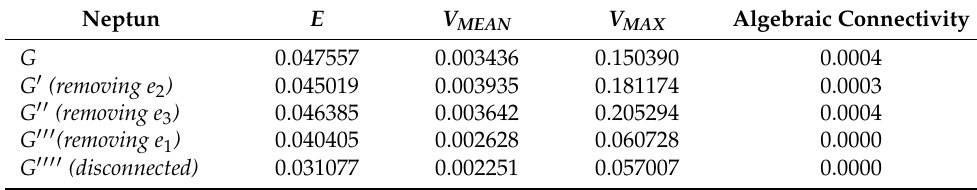
Table 5. Vulnerability measures.